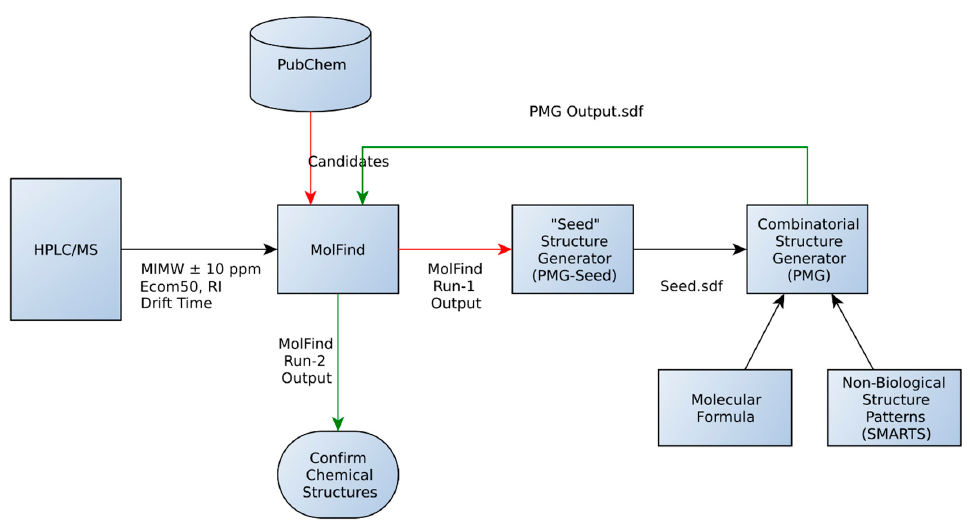
Figure 1. Database assisted structure identification (DASI) flowchart. See text for details.